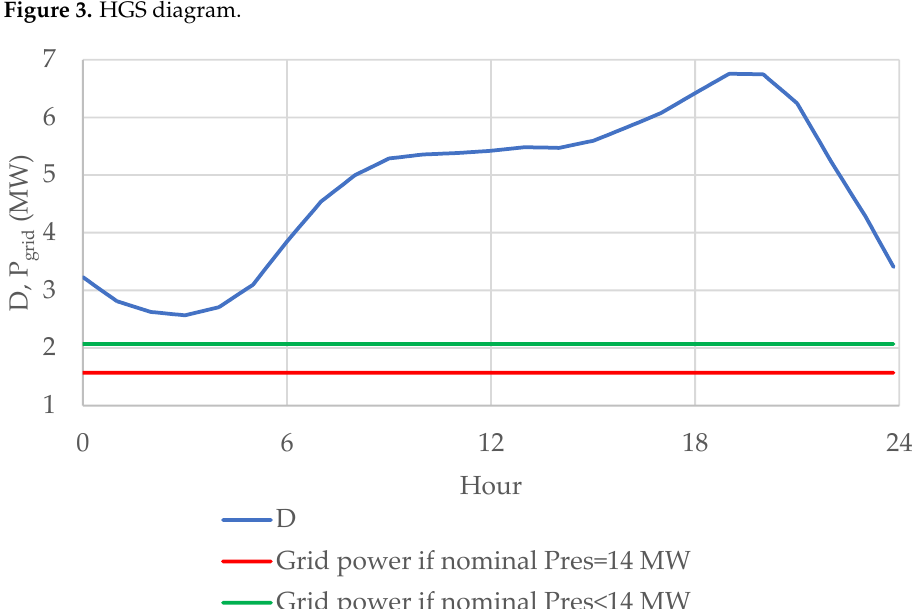
Figure 4. Consumption of power from the grid.